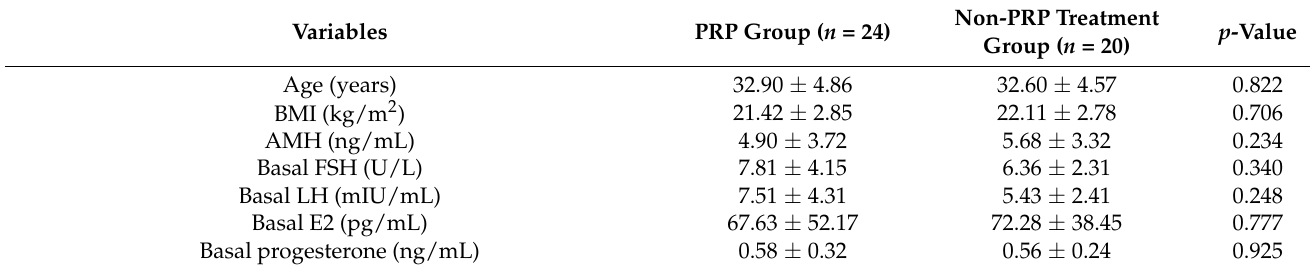
Table 3. Baseline characteristics and outcome variables of the cleavage-stage-embryo